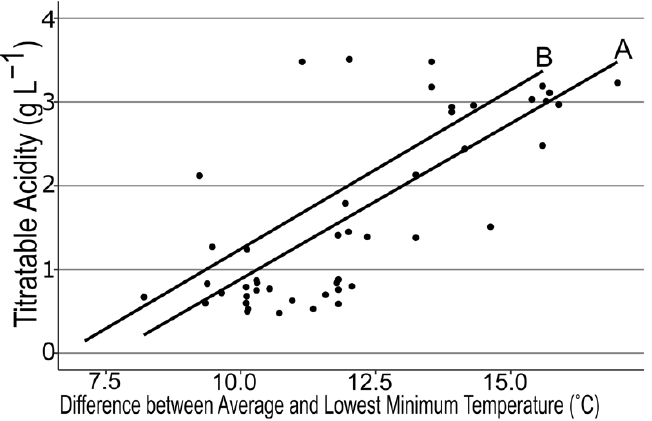
Figure 4. Regression between titratable acidity of strawberry fruit at harvest and the difference between mean air temperature and the lowest single temperature between first flower and green fruit (A) and green to pink fruit (B) for 16 farms across New York State visited in 2018, 2019, and 2020. A: y = 0.37x − 2.8, r = 0.7, p < 0.0001. B: y = 0.38x − 2.6, r = 0.74, p < 0.0001.